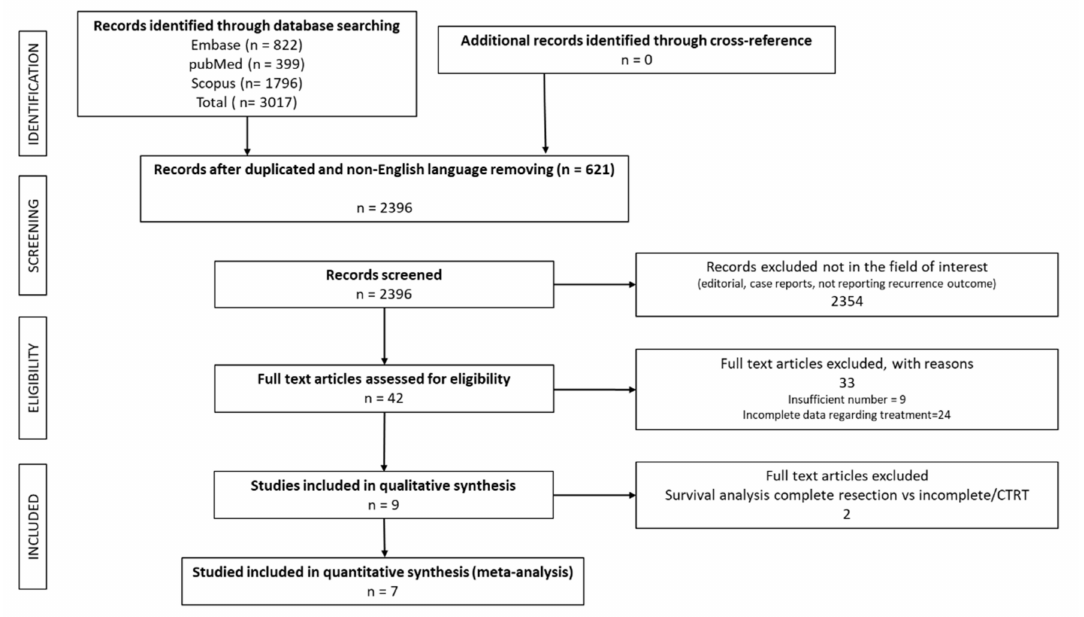
Figure 1. PRISMA diagram presenting the literature search and selection showing numbers of articles at each